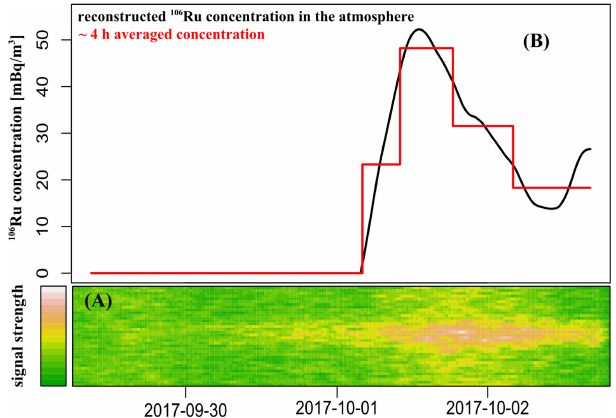
Figure 2. The response of the AMARA system to the 106 Ru con- tamination passing over during the corresponding sampling inter- val. (a) The 106 Ru signal increase in the 615–630keV energy re- gion after subtracting the radon background. (b) The example re- constructed real-time 106 Ru concentration and its 4h averaged val- ues, which corresponds to the CEGAM time resolution. Please note that the date format in this figure is year month day